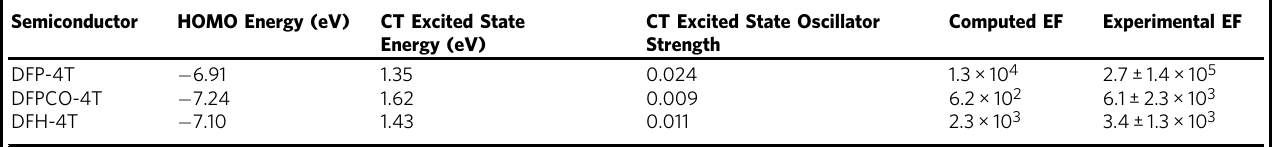
Table 1 Computational data a for the semiconductors and the semiconductor/MB complexes. Semiconductor HOMO Energy